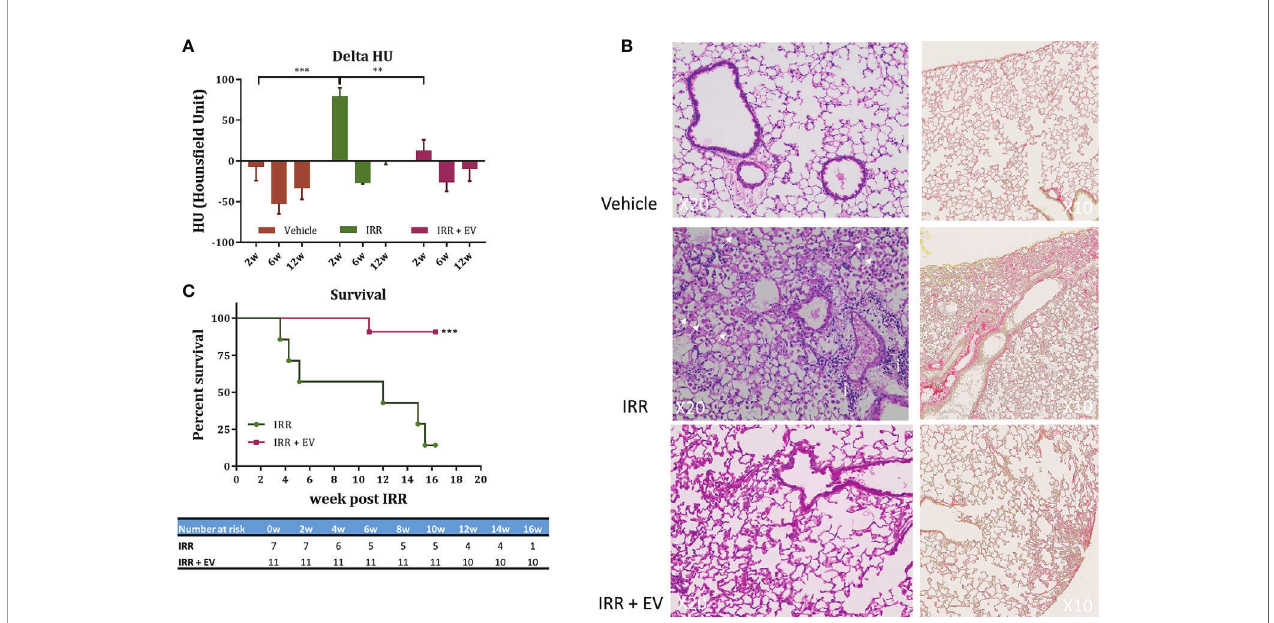
FIGURE 2 | EV therapy rescues mice from acute and delayed radiation injury. (A) Cone beam computed tomography (CBCT) was used to longitudinally investigate the occurrence of radiation-induced pulmonary density. Mice (n = 15) were imaged before irradiation to de fi ne a base-line level of lung density (HU) for each mouse. This measurement was used to normalize data over the time-course of the experiment. Mice were then divided in three groups: non-irradiated (n = 6), 14.4 Gy irradiated (n = 4), and 14.4 Gy irradiated + EV-treated mice (n = 5) and imaged at 2, 6, and 12-week post-irradiation. Results are expressed as the ratio between the value obtained at a dedicated time point and the initial base-line value (delta HU) ± SEM. Data were analysed using one-way ANOVA and Tukey test *** p < 0.0005 and ** p < 0.009. (B) Histological staining (HE and Sirius Red staining) showed typical late radiation-induced fi brosis remodeling 16 weeks post-RT. In controls, no signs of radiation injury were evident. However, in the single animal remaining in the IRR group, fi brotic indications included a thickening of alveoli with extracellular matrix and alveolar in fi ltration with spumous macrophages (arrow) and foci of in fl ammatory cells (i). In contrast, EV-treated animals showed reduced signs of radiation injury and fi brosis (image/s derived from an animal showing minimal pulmonary fi brosis). (C) Survival curves. The percent survival of irradiated (RT) and irradiated plus EV treated (RT+EV) cohorts is shown. Data were analyzed using the log-rank statistical test, *** p <